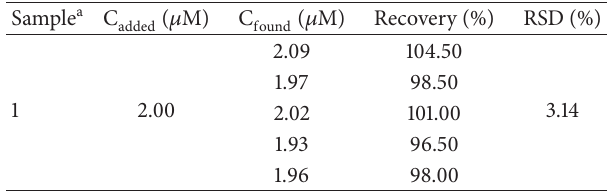
Table 2: Determination of catechol content in real water samples ( 𝑛 = 5